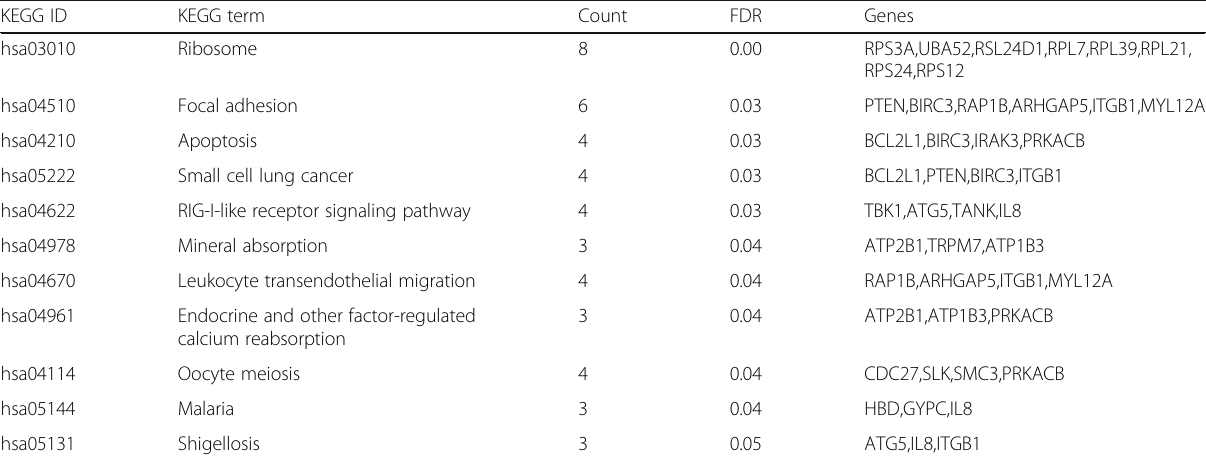
Table 4 The significantly enriched pathways for the common differentially expressed genes in T2D, CAD, and T2D + CAD KEGG ID KEGG